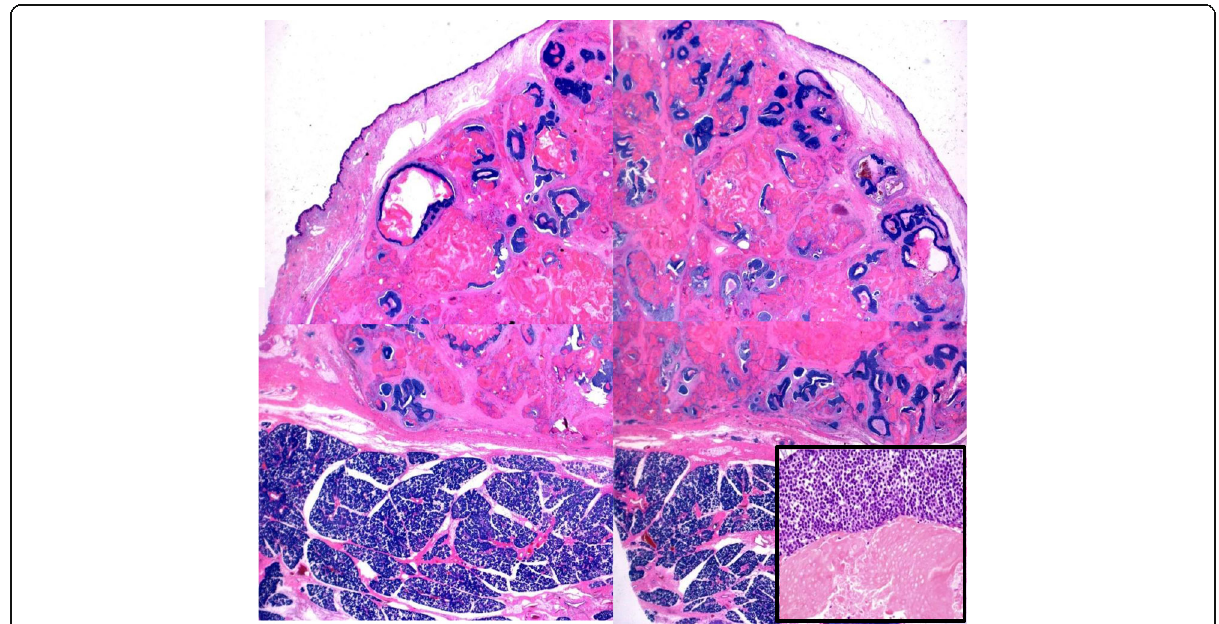
Fig. 4 Histological findings of the tumor. The resected tumor cells consisted of shadow cells, and basophilic cells were confirmed at the periphery of the tumor. A normal parotid gland was located in the lower portion (H&E staining, scanning view). Basophilic cells and shadow cells (inset) (H&E staining, × 400)